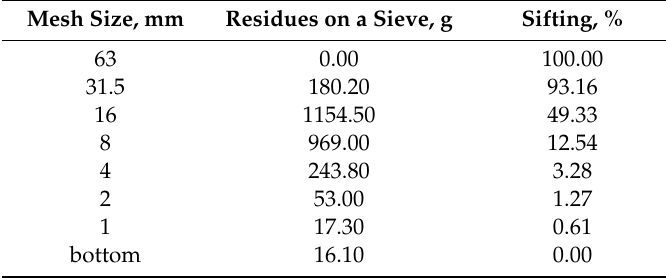
Table 2. Results of sieve analysis. Glass cullet.